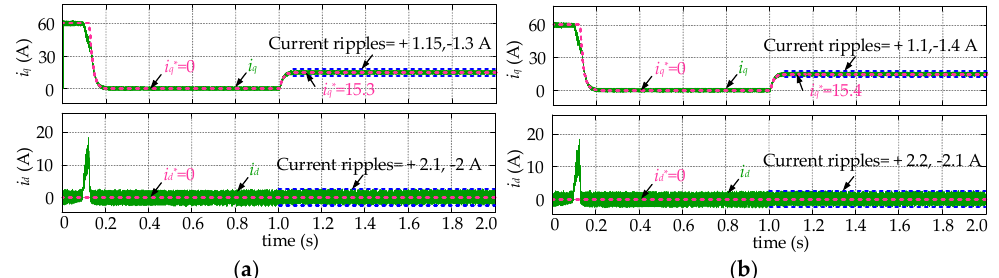
Flux linkage used for control increases 0.03 Wb (0.105 Wb).